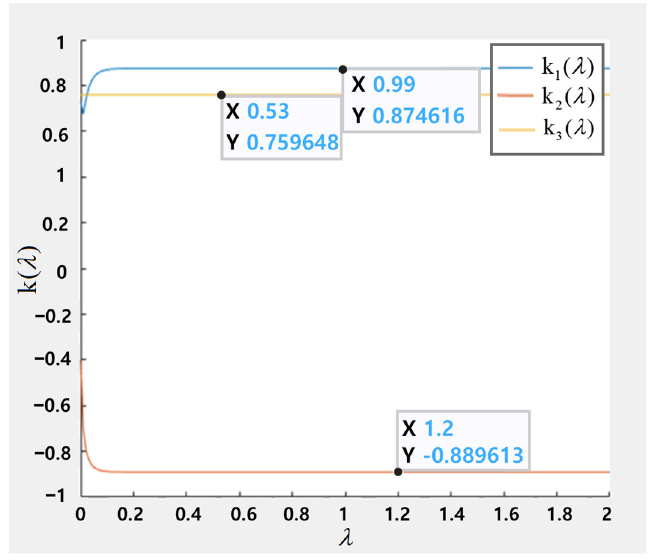
Figure 3.   (λ) by the parameters in Table 1. Figure 3. k i ( λ ) by the parameters in Table